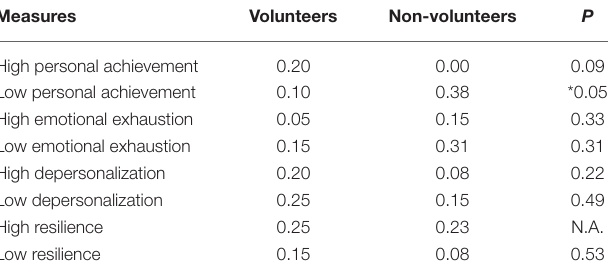
TABLE 4 | Comparison of high and low scorers on burnout and resilience measures across volunteers and low volunteers show a significantly lower proportion of low scorers in personal achievement in the volunteers as compared to non-volunteers, P = 0.05.